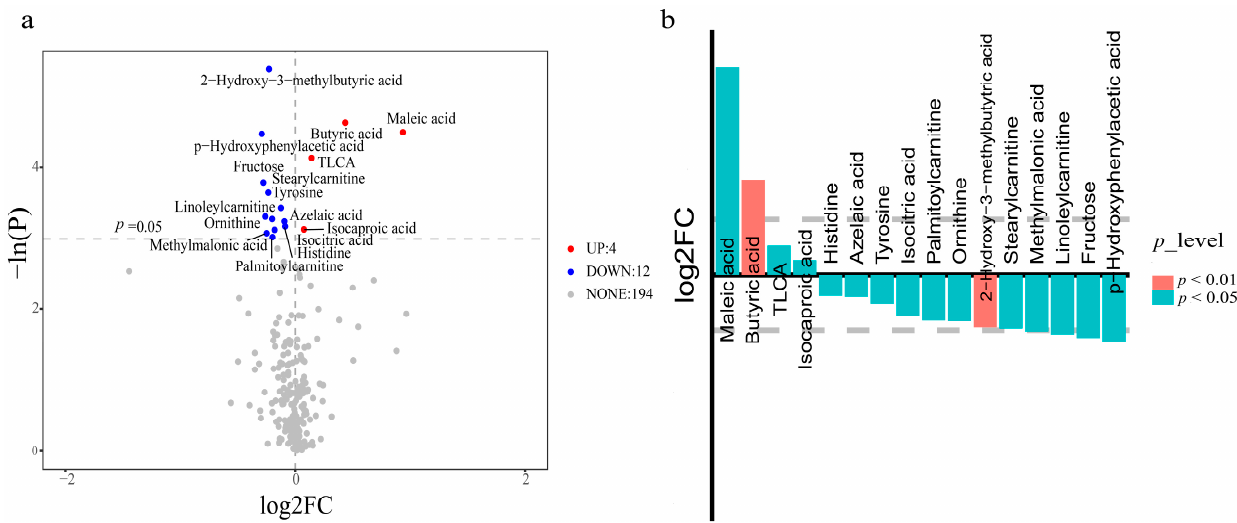
Figure 2. Metabolite profiles of two groups are visualized in (red, upregulated in the FET group, blue, downregulated in the FET group) ( a ) and bar plot (the criteria is log2fc>1, the upper part, upregulated in the FET group, the lower part, downregulated in the FET group) ( b ).